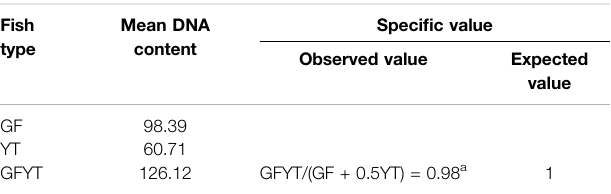
TABLE 3 | Mean DNA content in GF, YT, and